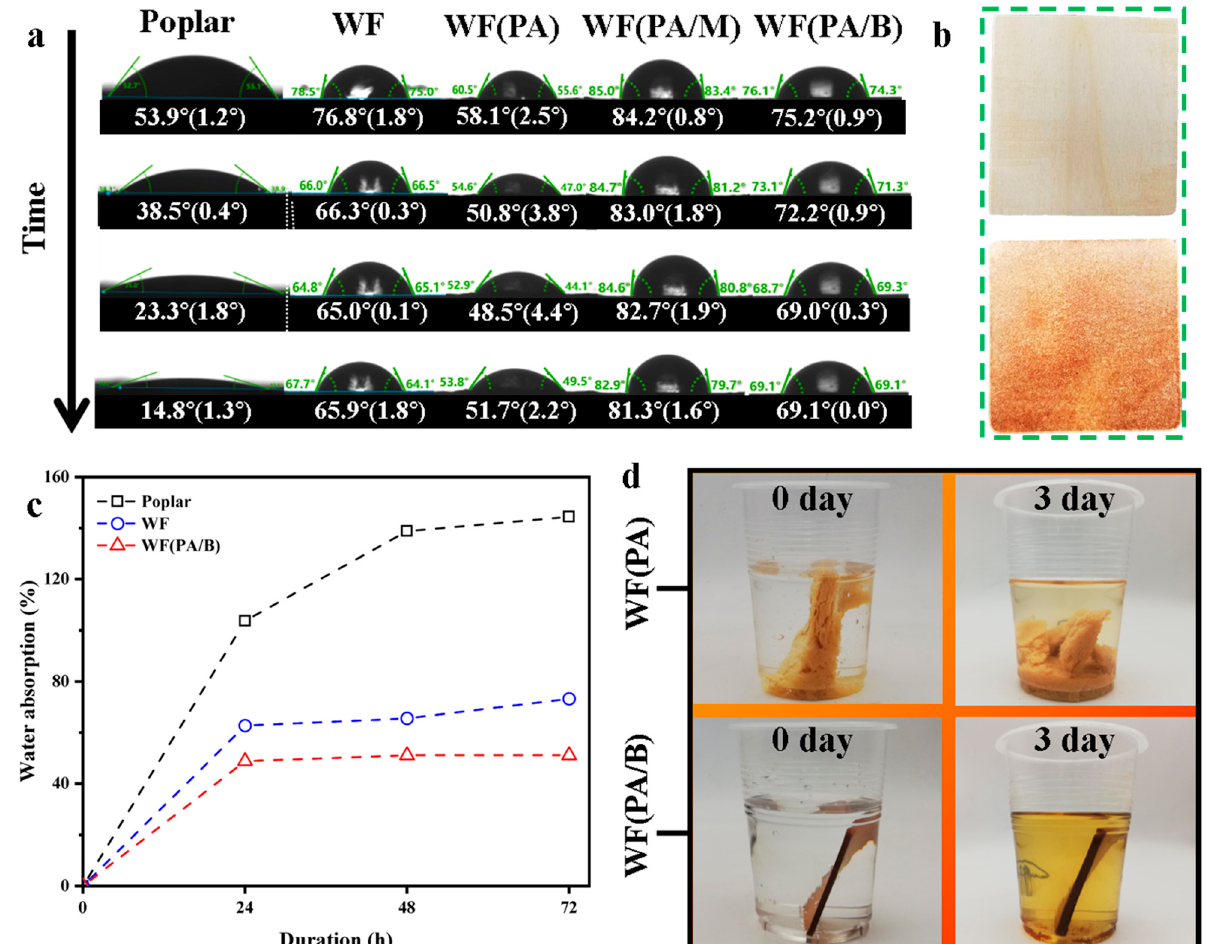
Figure 3. ( a ) Contact angle of poplar and multiple biocomposites at 0 s, 2 s, 5 s and 10 s. ( b ) Image of the surface of poplar and WF(PA/B). ( c ) Water absorption of WF, WF(PA/B) and poplar. ( d ) The water absorption process of WF(PA) and WF(PA/B).